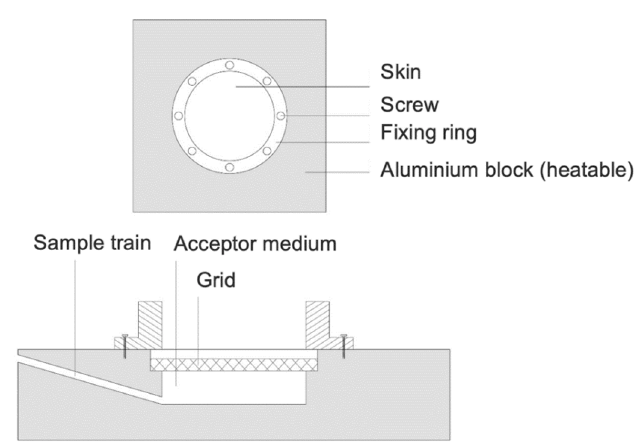
Figure 1. Penetration cell for in-situ CRM measurements.